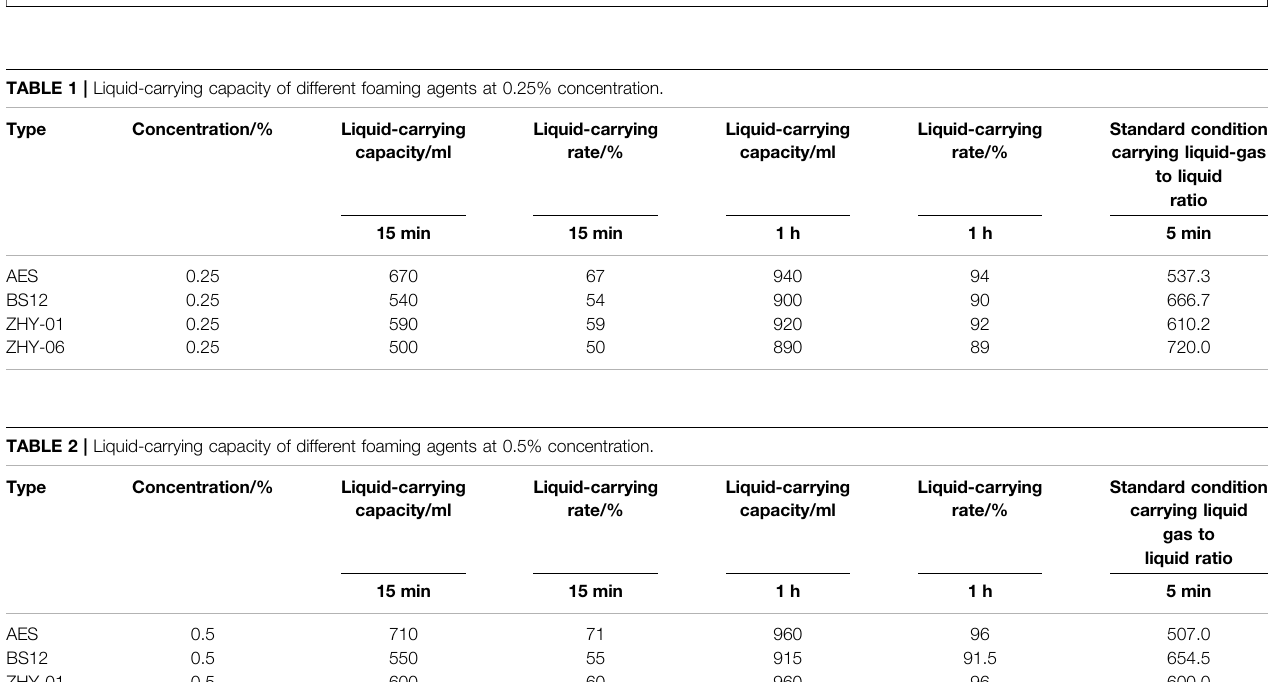
FIGURE 2 | Dynamic process of drainage and gas recovery.